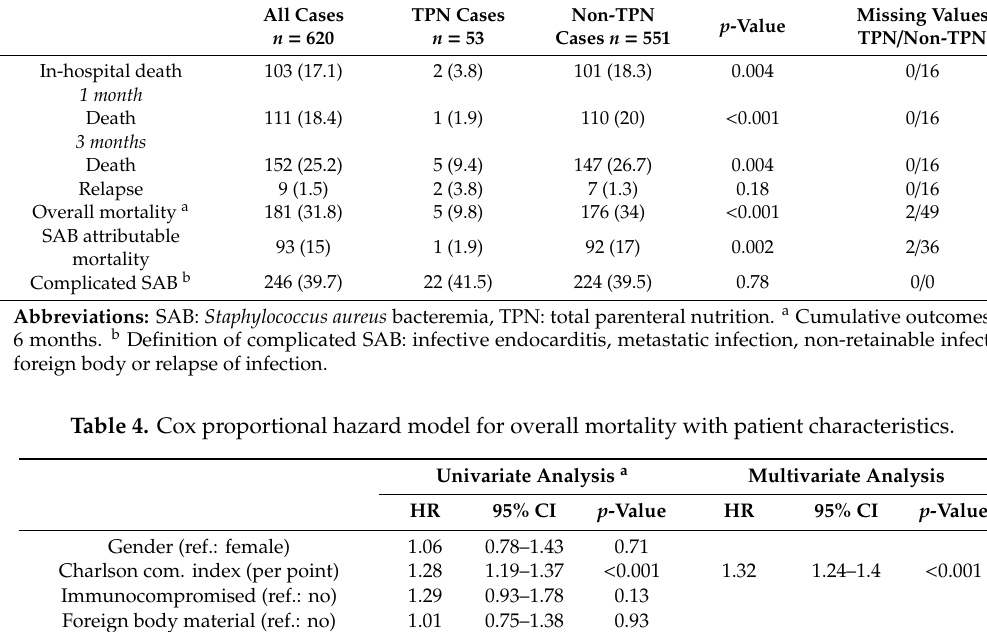
Figure 4. Multivariate Cox regression curves for survival time in patients with S. aureus bacteremia. (HR 0.38, CI 0.16–0.93, p = 0.03; adjusted for Charlson comorbidity index and presence of risk factors for endocarditis). TPN: total parenteral nutrition.